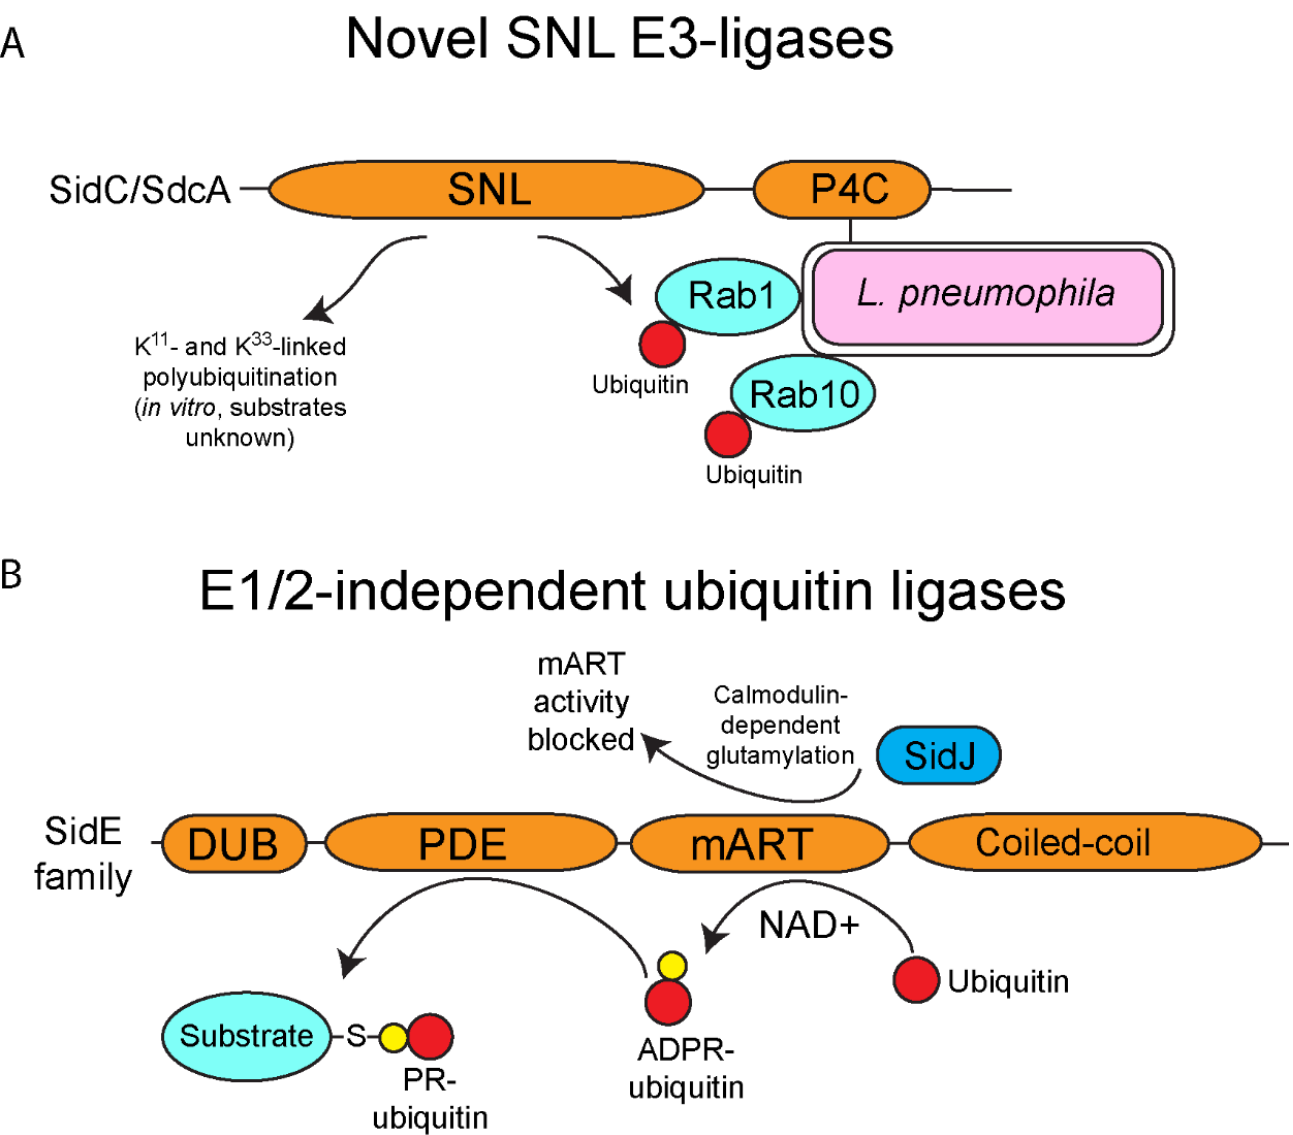
Figure 2. Novel ubiquitin ligases of L. pneumophila . L. pneumophila possesses multiple effectors that exhibit ubiquitin ligase activity but do not show any homology to any known eukaryotic ligases. ( A ) Novel SNL E3-ligases of L. pneumophila . L. pneumophila injects two paralogous effectors (SidC and SdcA) that possess the SidC N-terminal ubiquitin ligase (SNL) domain, which catalyzes K 11 - and K 33 -linked polyubiquitin linkages (in vitro), and direct monoubiquitination of host Rab1 and Rab10. Both effectors associate with the outer leaflet of the LCV membrane via their C-terminal PI4P binding domain. SidC/SdcA contribute to ER-derived vesicle recruitment to the LCV. The SNL domain has not been found in eukaryotic ubiquitin ligases. ( B ) E1/2-independent ubiquitin ligases of L. pneumophila . The E1/2-independent ubiquitin ligases of the SidE family are the first known ubiquitin ligases that function completely independently of the canonical activity of the E1 and E2 enzymes. The mART domain of the SidE family catalyzes the formation of ADP-ribosylated ubiquitin using NAD+ as a substrate. The PDE domain of the SidE family can then use ADP-ribosylated ubiquitin to add phosphoribosylated-ubiquitin to serine residues to substrate proteins, such as host Rab proteins and Rtn4. Activity of the SidE family is regulated by the metaeffector, SidJ, which catalyzes calmodulin-dependent glutamylation of the mART domain, and this blocks activity of this